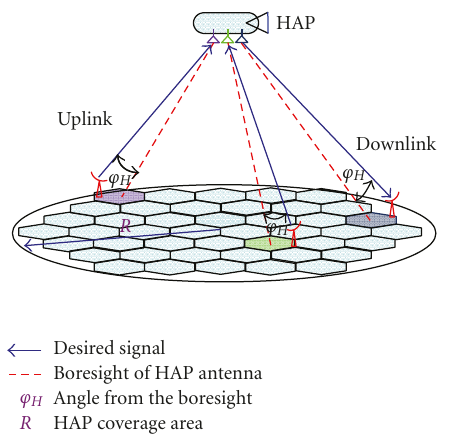
Figure 1: HAP cellular system with a multiantenna payload serving multiple cells.